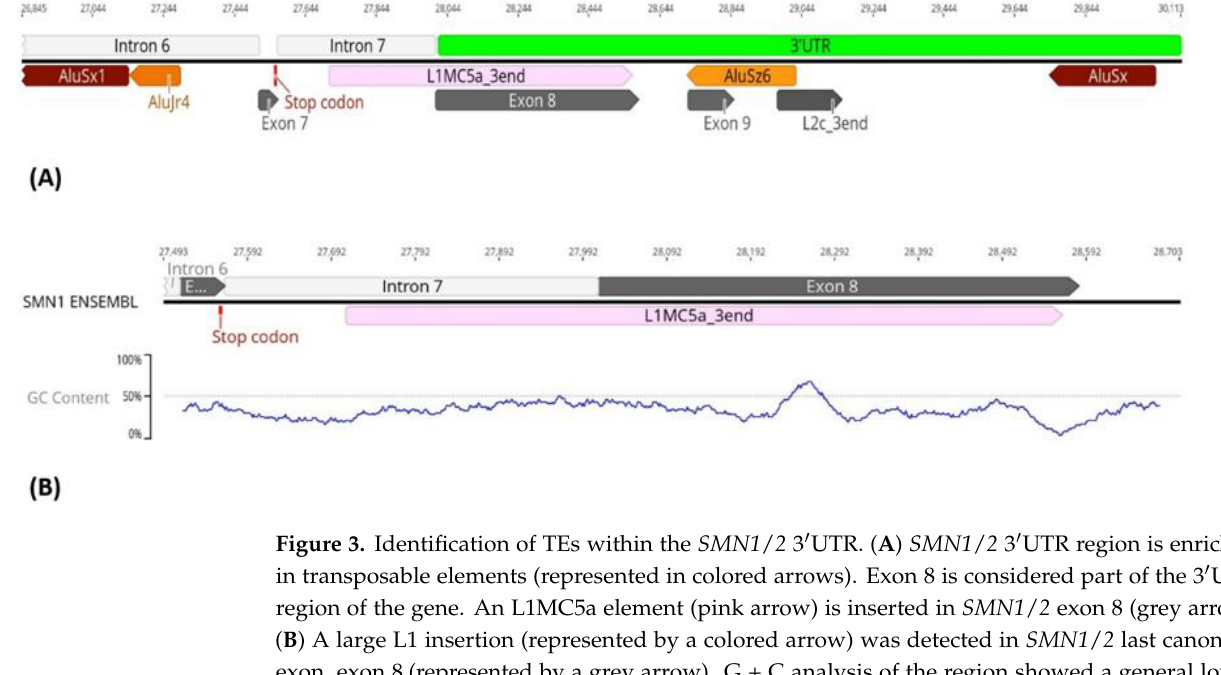
Figure 3. Identification of TEs within the SMN1 / 2 3 (cid:48) UTR. ( A ) SMN1 / 2 3 (cid:48) UTR region is enriched in transposable elements (represented in colored arrows). Exon 8 is considered part of the 3 (cid:48) UTR region of the gene. An L1MC5a element (pink arrow) is inserted in SMN1 / 2 exon 8 (grey arrow). ( B ) A large L1 insertion (represented by a colored arrow) was detected in SMN1 / 2 last canonical exon, exon 8 (represented by a grey arrow). G + C analysis of the region showed a general lower G + C content in this region compared with the adjacent gene regions, partially explaining how a L1 insertion occurred in this region.